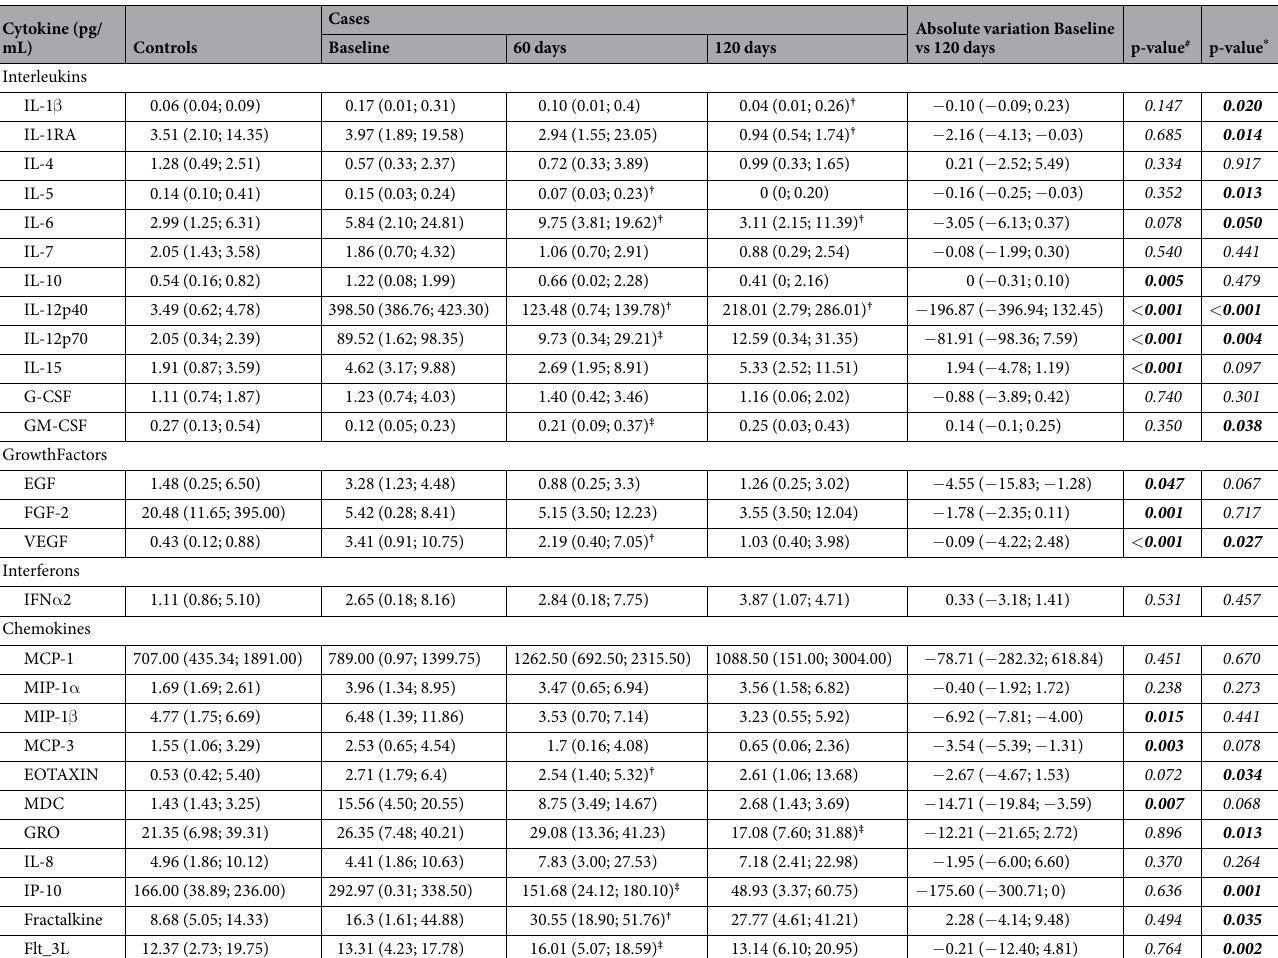
Table 3. Aqueous cytokine levels at baseline and during the follow-up. Cytokine levels are expressed as median and Interquartile range (IQR). * Friedman test evaluating variation in cytokine levels among time; † p < 0.05, ‡ p < 0.01 pairwise post-hoc analysis vs previous. measurement. Bolded p-value were significant after FDR correction. # Baseline vs controls. For same cytokines, the concentration values were at the lowest test sensitivity threshold; therefore exact concentration values are not presented. The excluded cytokines were IL-1 α , IL-2, IL-9, TGF α , IFN γ , sCD40L and TNF α .